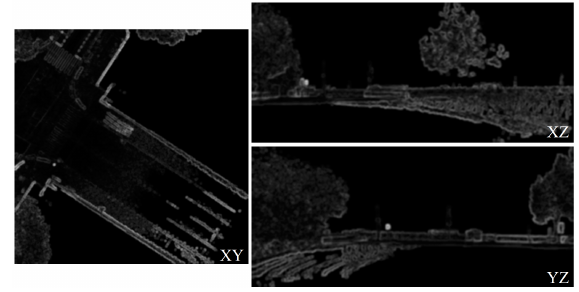
Figure 8. The three images produced from the point cloud set of Figure 1a illustrating gradient of intensity values.